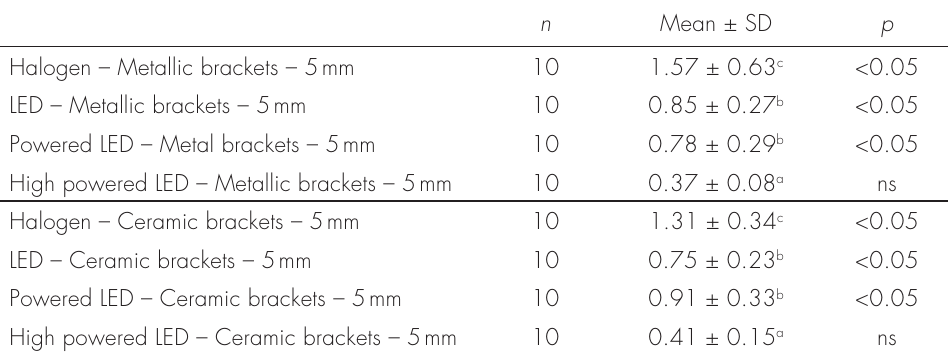
Table VI. Comparisons of pulp chamber temperature changes with light sources irradiated at 5